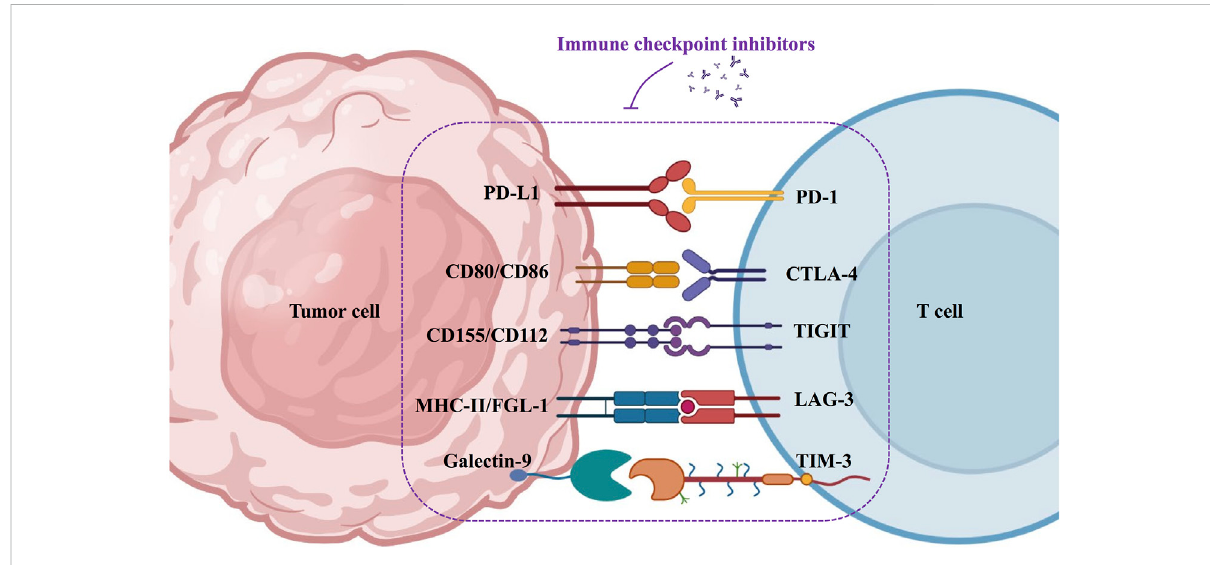
FIGURE 3 Schematic diagram of immune checkpoint inhibitors in immunotherapy for